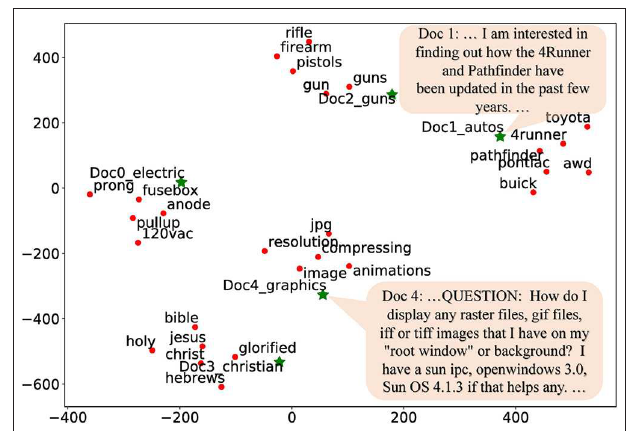
FIGURE 4 | Word and document embedding visualization.